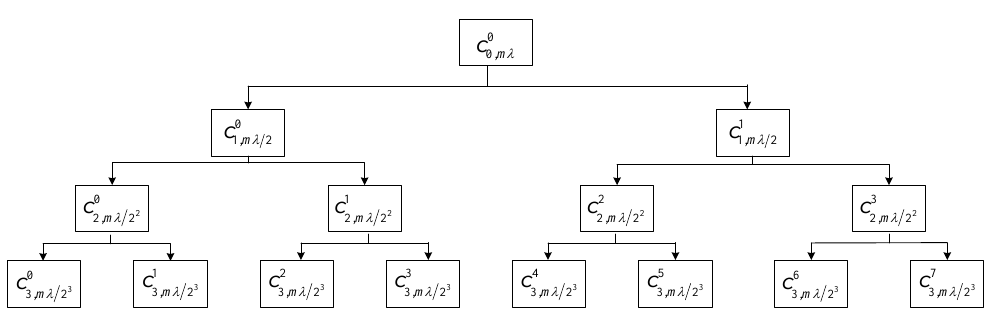
Figure 3. Schematic diagram of Mallat decomposition of wavelet packet at scale l = 3.